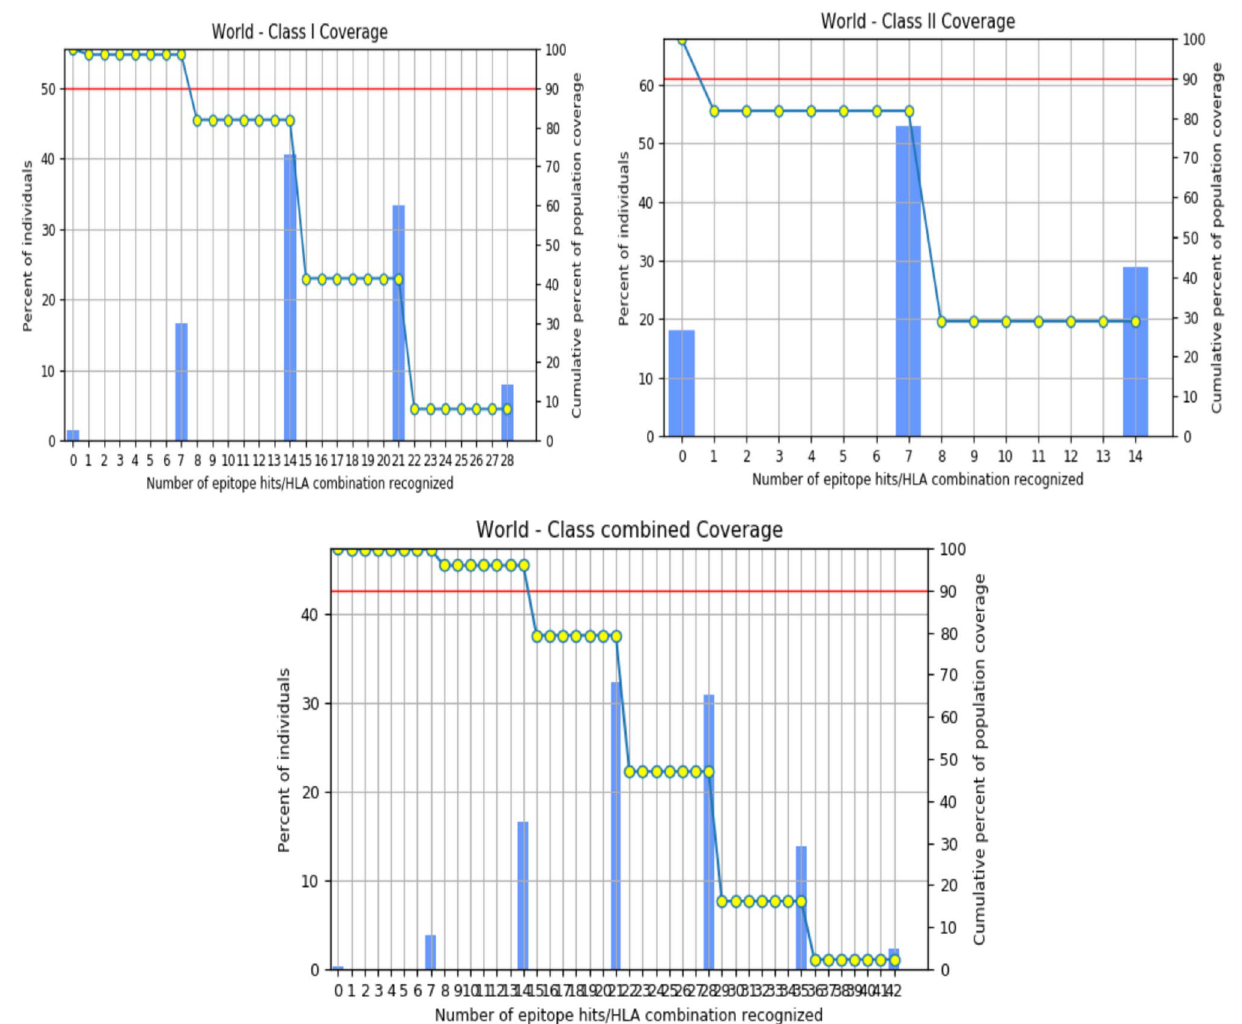
Figure 6. World class I, class II and combined coverage of HLA alleles recognized a set of predicted T cell